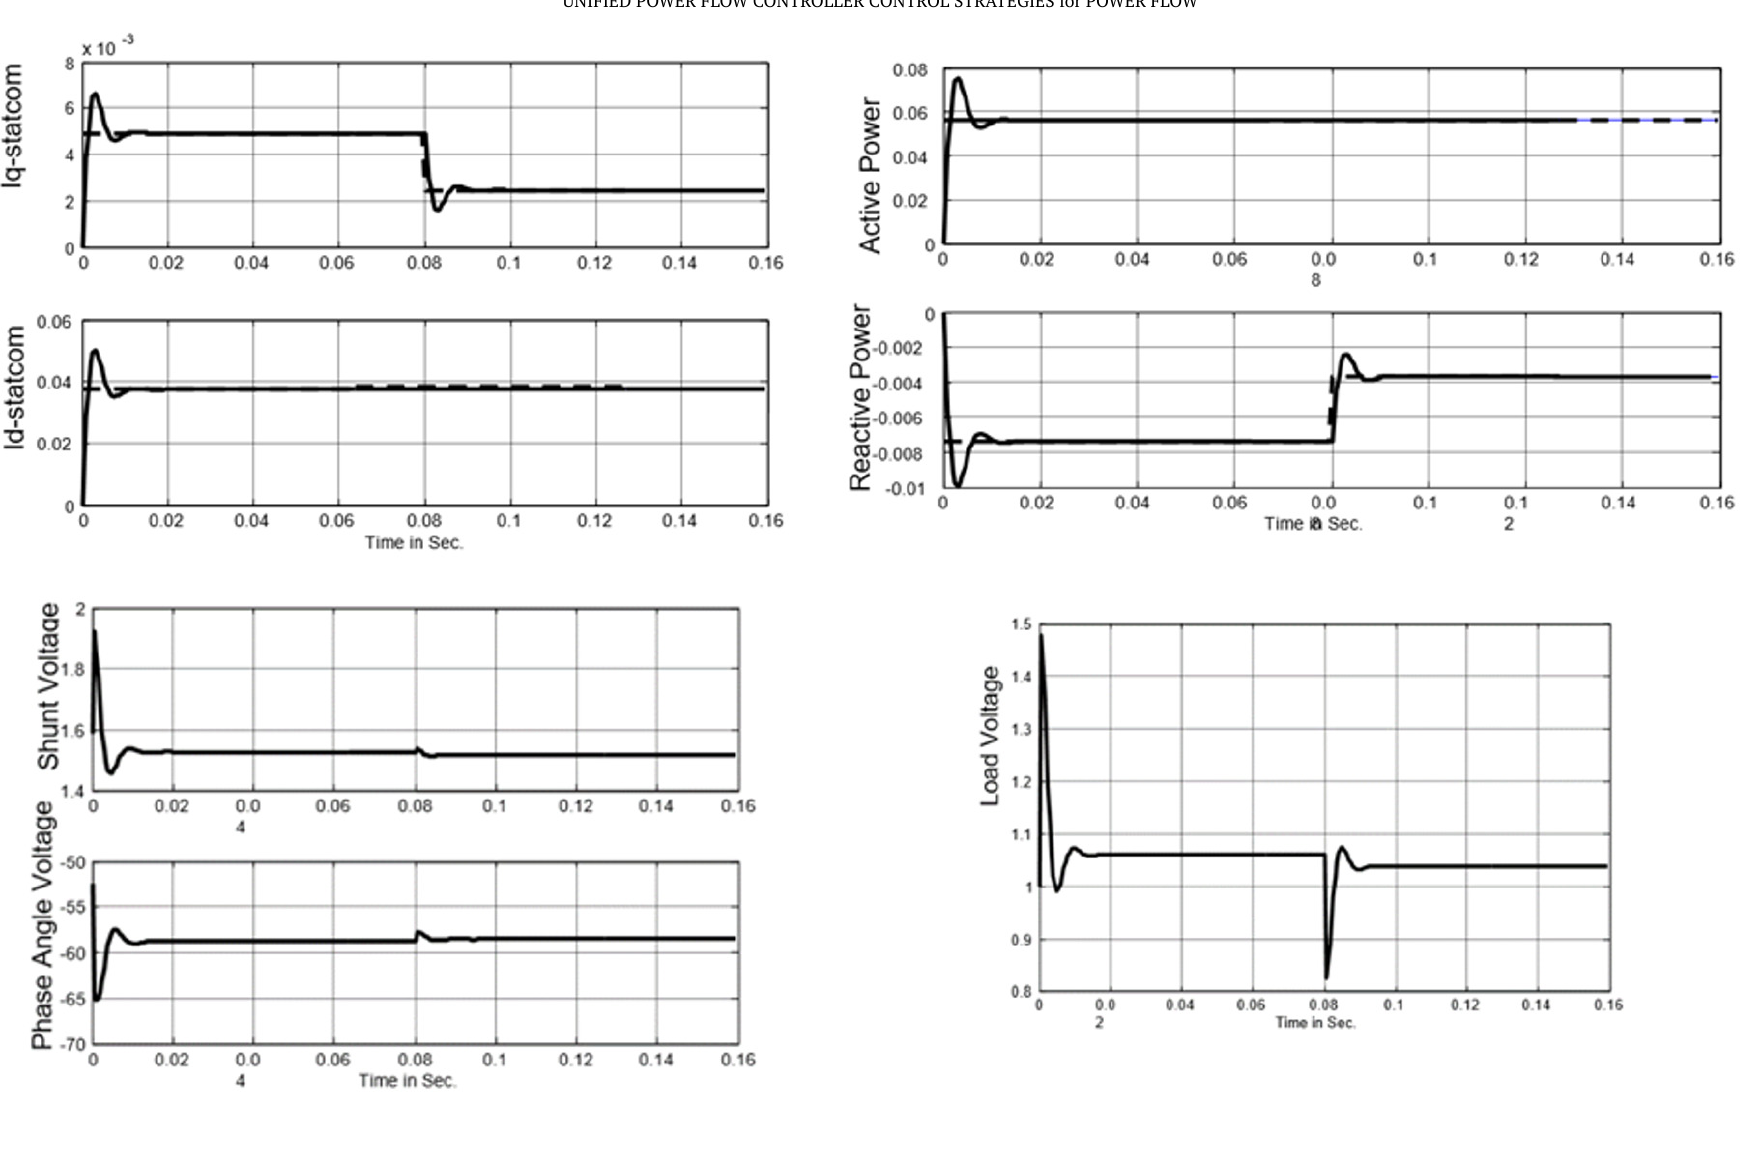
Figure 9. The transient performance of the STATCOM in case of reactive power variation with